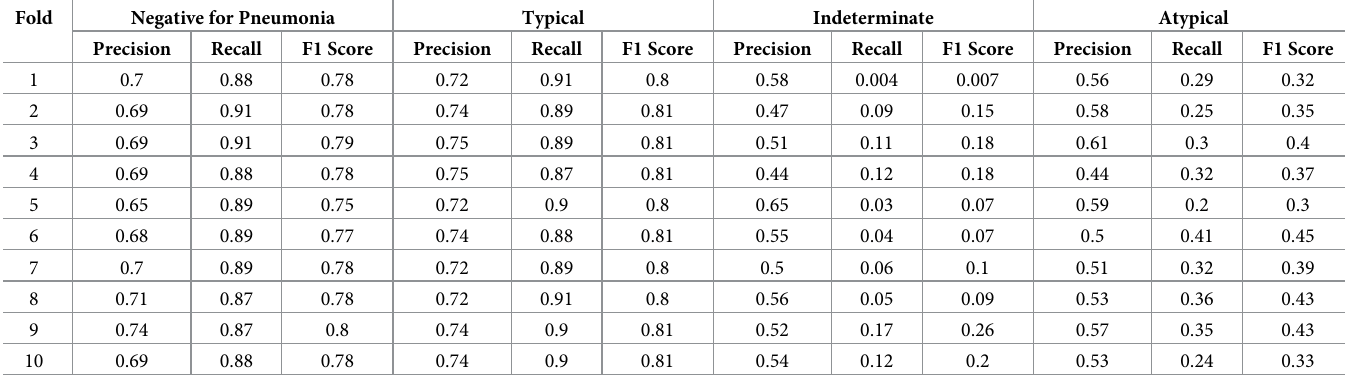
Table 3. Model performance